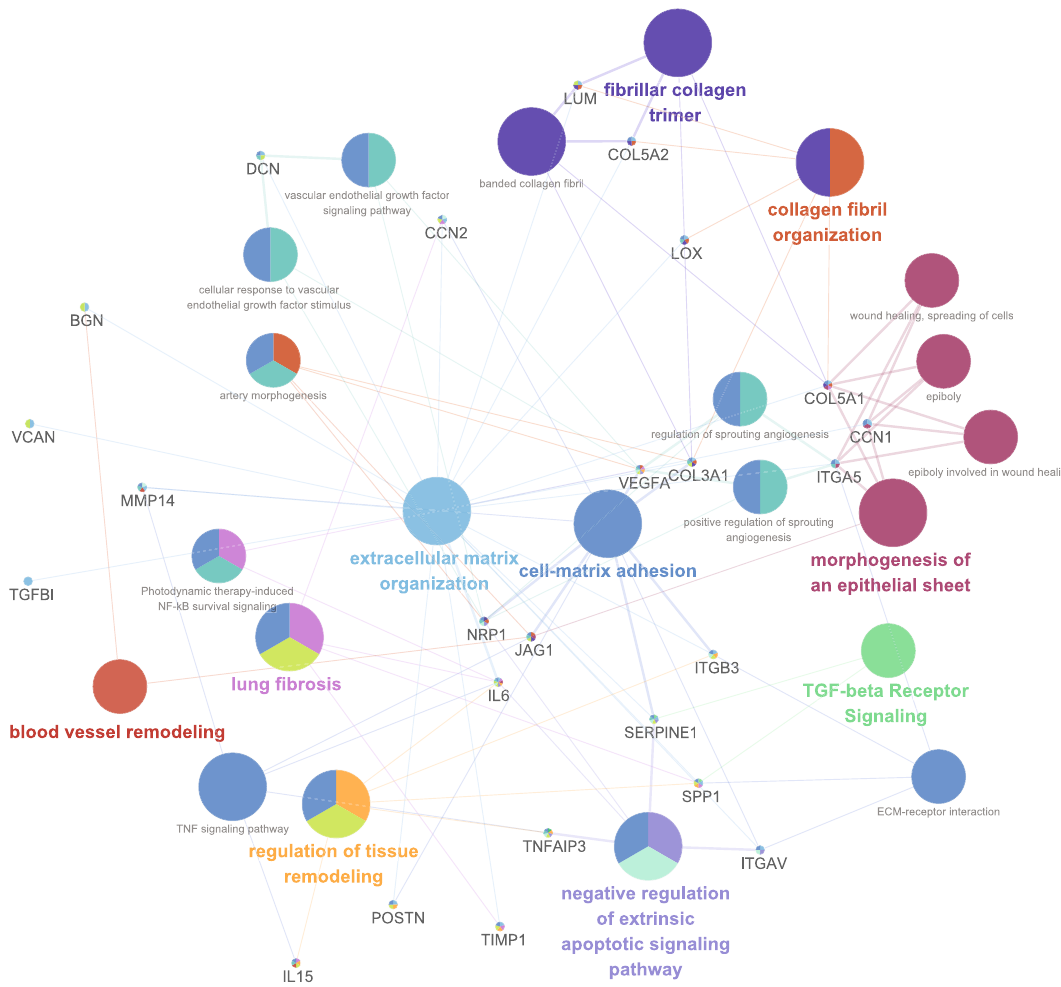
Figure 4. Grouping of networks based on functionally enriched Gene Ontology (GO) terms and pathways associated with the presence of cancer-associated samples with CAFs than in those without CAFs ( p < 0.001). CD8+T cells showed a tendency to be decreased in samples with CAFs, but this trend was not statistically significant ( p = 0.602) (Fig. 3A). The presence of CAFs was associated with higher proliferation and matrix metallopeptidase-11 (MMP- 11), interleukin-6 (IL-6) and transforming growth factor-β (TGF-β) levels than the absence of CAFs ( p < 0.001, < 0.001, = 0.015 and < 0.001, respectively) (Fig. 3B). CAFs were linked to blood vessel remodeling, fibrosis and tissue remodeling pathway. We performed pathway-based network analysis using the genes and gene sets associated with CAFs. The CAFs were linked to 10 functionally enriched Gene Ontology (GO) terms and pathways: (1) blood vessel remodeling; (2) lung fibrosis; (3) regulation of tissue remodeling; (4) extracellular matrix organization; (5) cell–matrix adhesion; (6) fibrillar collagen trimer; (7) negative regulation of extrinsic apoptosis signaling pathway; (8) collagen fibril organization; (9) morphogenesis of an epithelial sheet; and (10) TGF-β receptor signaling (Fig. 4). CAFS improved survival prediction using machine learning.. In the TCGA data, the distributions of the five predominant histological types were as follows: 7 lepidic type (1.4%), 115 acinar type (22.2%), 107 papillary type (20.7%), 65 micropapillary type (12.6%) and 223 solid type (43.1%). There was an absence of CAFs in the lepidic cases; thus, they were not included in the survival analyses. The presence of CAFs was associated with unfavorable DFS and DSS in the acinar type ( p = 0.039 and 0.067, respectively), but the relationship between CAFs and DSS was not statistically significant. The presence of CAFs was significantly related to shorter DFS and DSS than the absence of CAFs in the papillary type ( p < 0.001 and 0.019, respectively). The presence of CAFs correlated with worse DFS and DSS in the micropapillary type ( p = 0.47 and 0.069, respectively), but the correlations were not statistically significant. In the solid type, the presence of CAFs was significantly associated with shorter DFS and DSS than the absence of CAFs ( p = 0.007 and 0.002, respectively) (Fig. 5A,B). After adjustment for confounders including T stage, N stage, age, sex and smoking